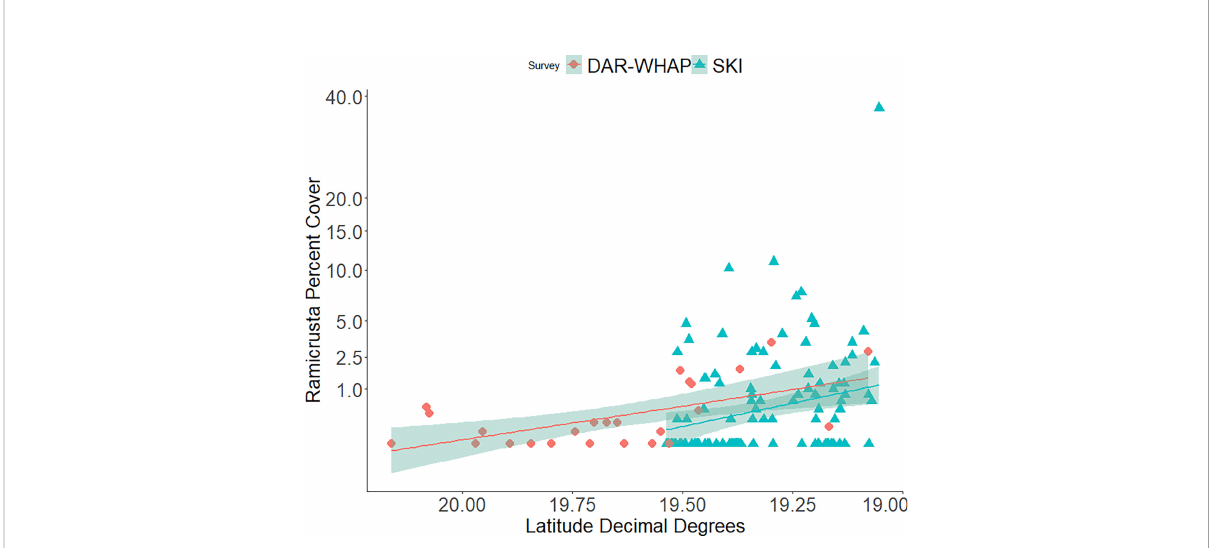
FIGURE 9 Average percent cover of Ramicrusta at DAR-WHAP sites and SKI sites from north to south in 2020. Ramicrusta percent cover shows higher abundance at several of the southern survey sites at 19.50 latitude and farther south. Trend lines indicate the best fi t line with the shaded regions showing the standard